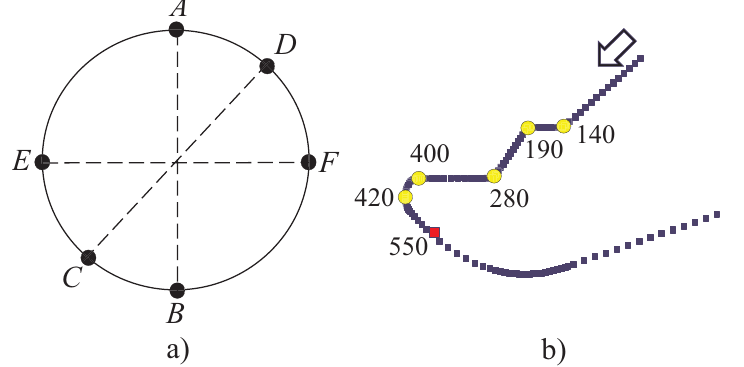
Figure 5. Location of control points ( a ) and direction along nozzle contour ( b ) for star-shaped